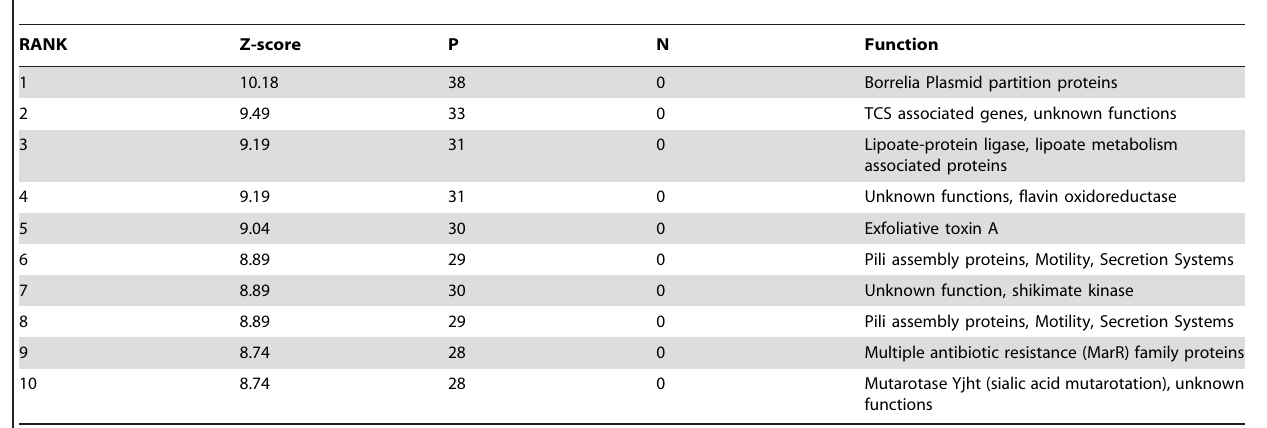
Table 5. Top 10 ranking pathogenic protein families and annotated functions of their proteins for the WDM model.